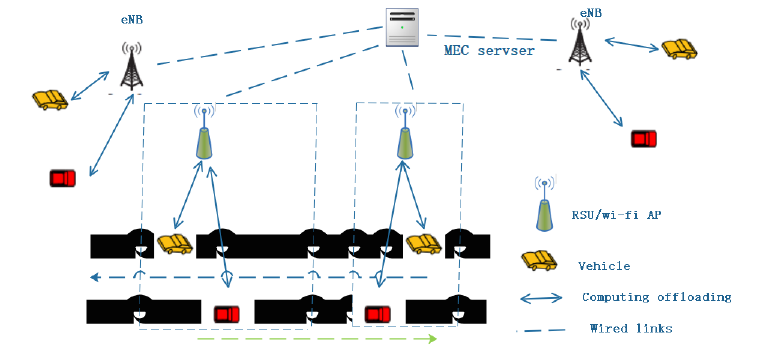
Figure 1. The structure of VNET model based on